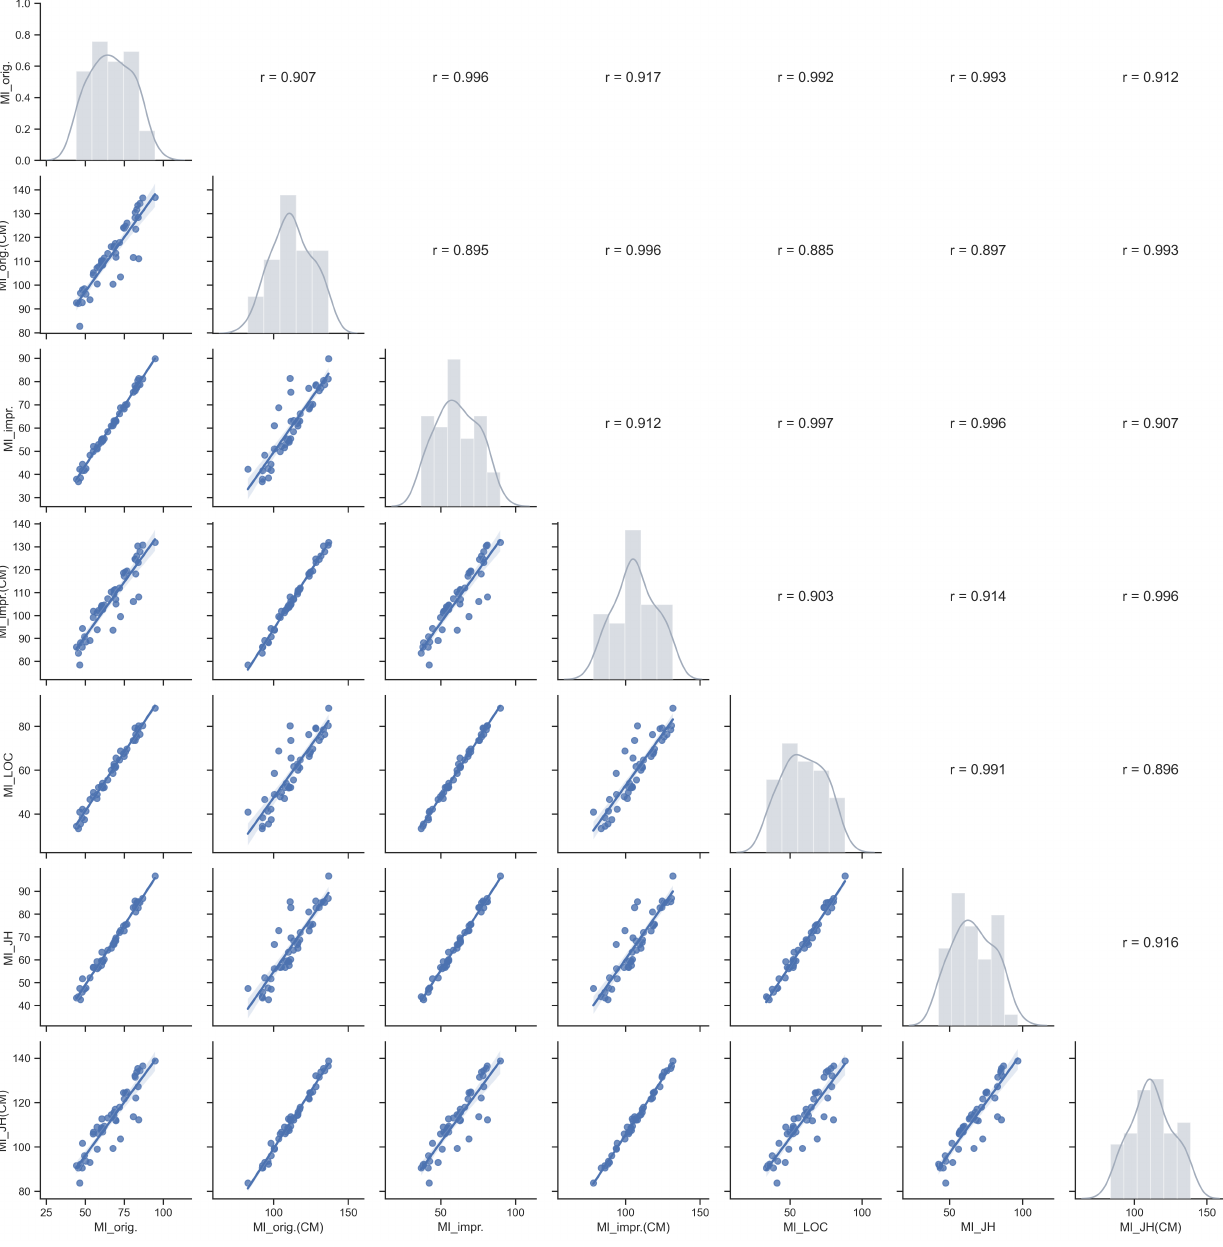
Figure 5. Scatter plot matrix representing pairwise correlation analyses (all reported correlations are significant ( p < 0.001)) and variation in the data